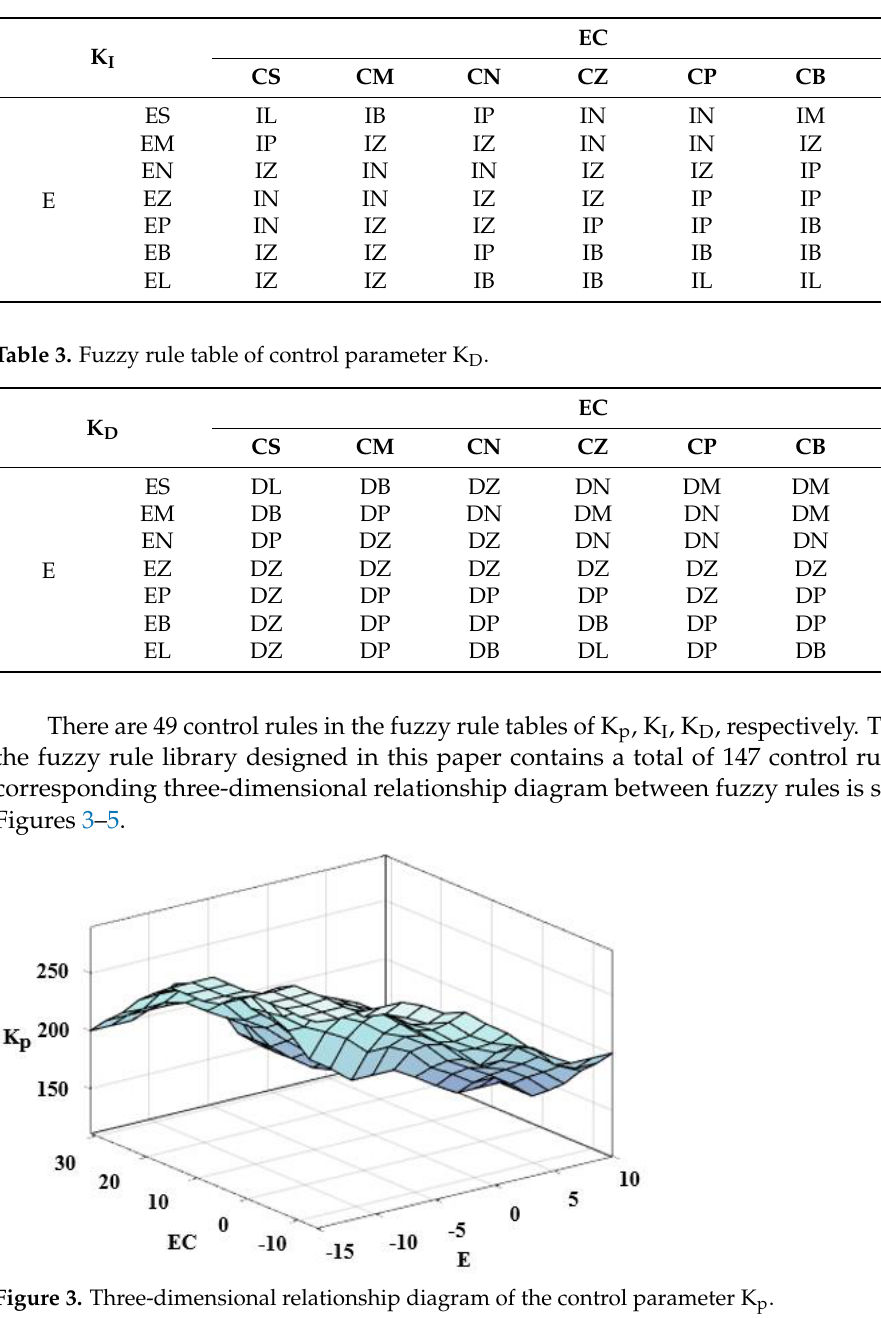
Table 2. Fuzzy rule table of control parameter K I .